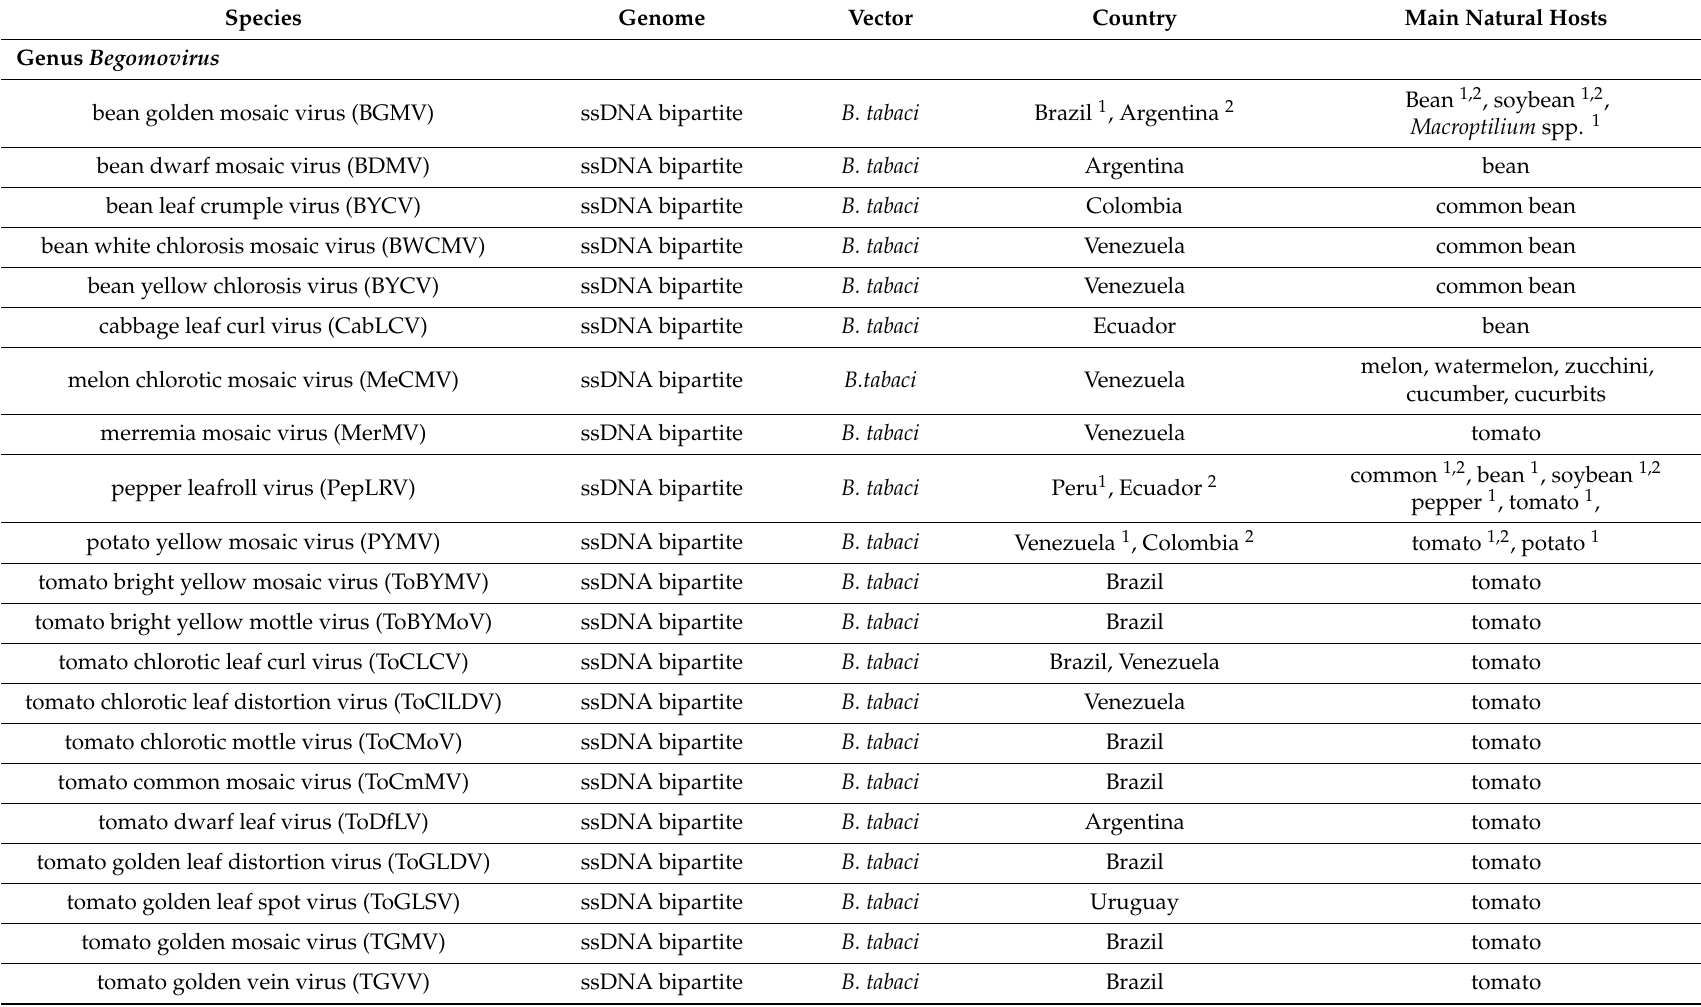
Table 1. Main whitefly-transmitted viruses present in South